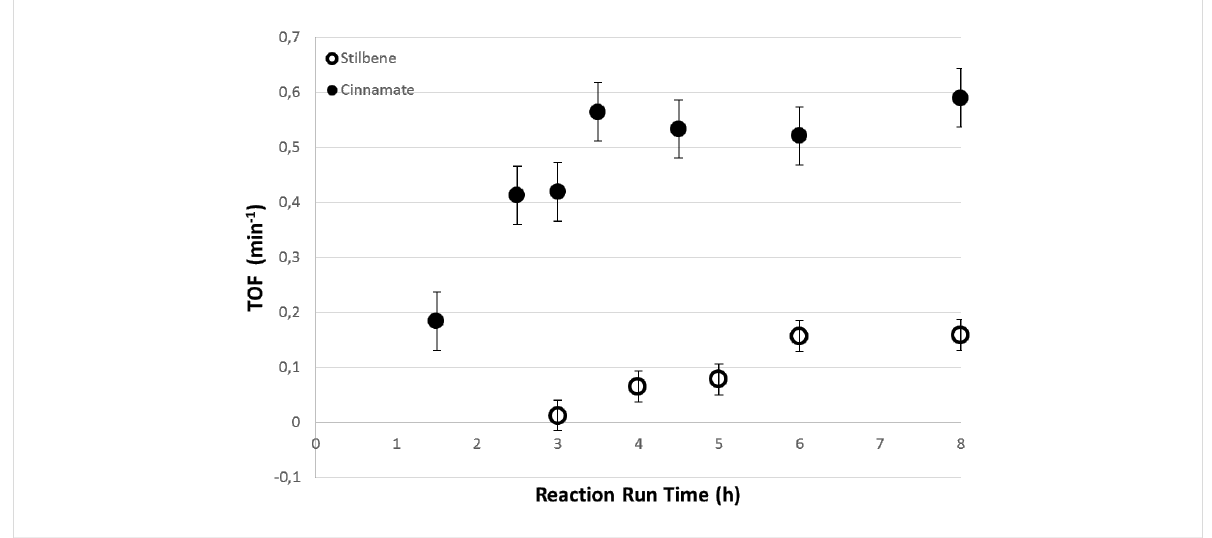
Figure 9: Turnover frequencies of the Heck reactions at 155 °C using styrene ( ο ) as combined isomeric products, and methyl acrylate ( ● ) as a func- tion of reactor run time for the 1 mm internal diameter plug flow reactors.